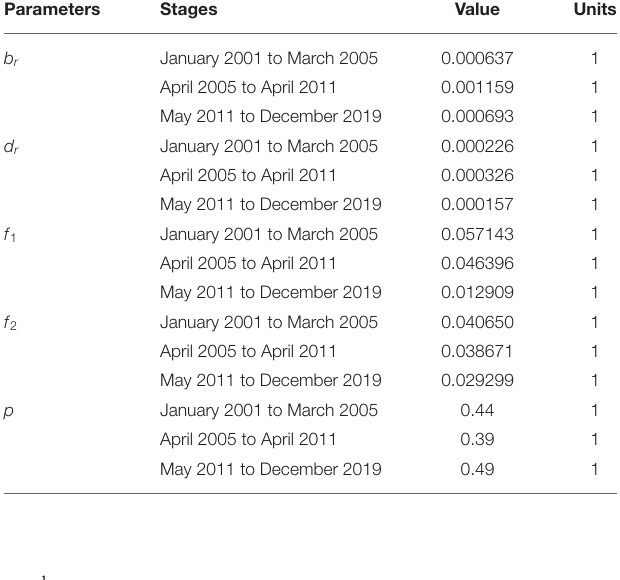
TABLE 3 | The value of parameters of br , dr , f 1 , f 2 and p in detail.